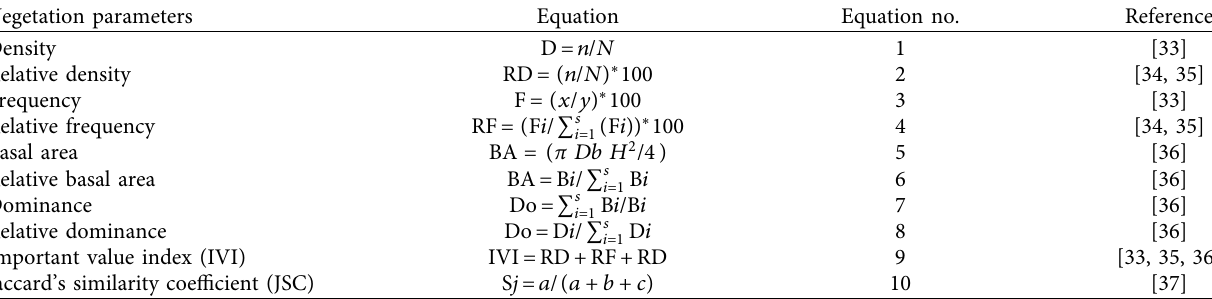
Figure 3: (Photo 1) Feature of the study sites. Source: Semegnew T (2020). (a) Site I (Janje–Dope). (b) Site II (Newi–Baya). (c) Site III (Gonchi–Gelesha). (d) Site IV (Gumare–Kabo). Table 3: List of equations used for the calculation of vegetation